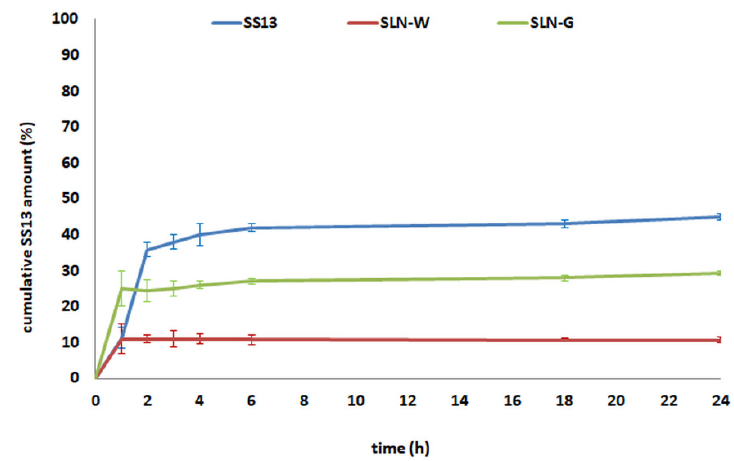
Figure 11. In vitro release kinetics of SS13 from SLN-W and SLN-G compared to the dissolution of free molecule. Data are reported as mean ± SD (n = 3).